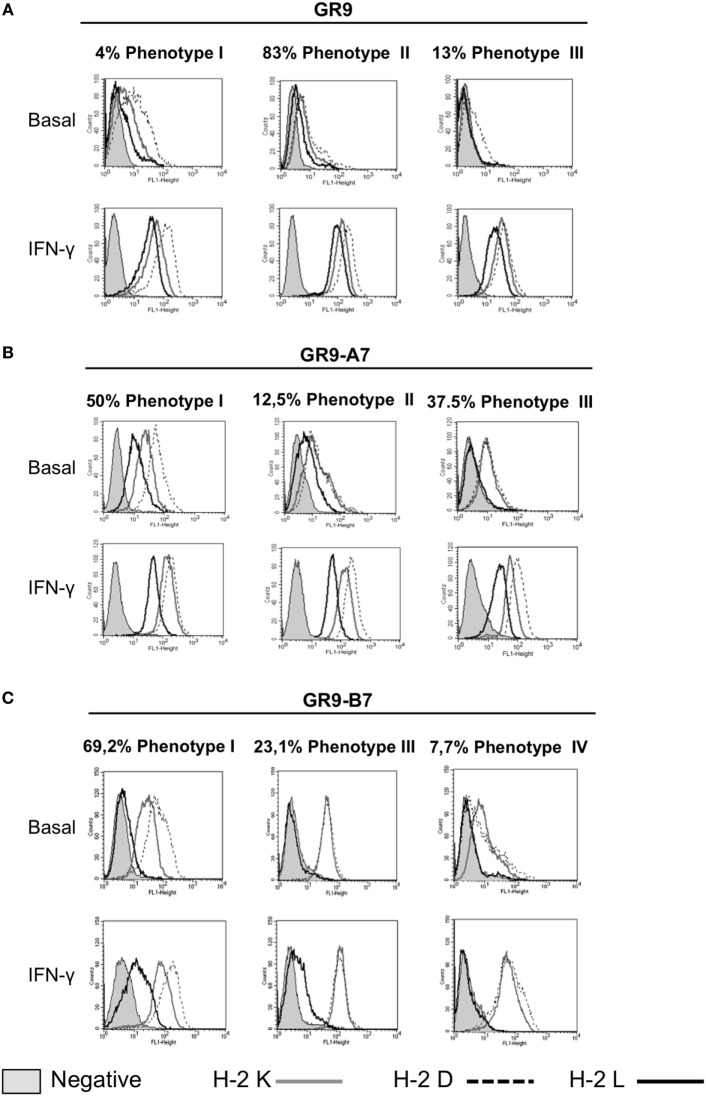
MHC-I phenotypes of GR9, GR9-A7, and GR9-B7 spontaneous metastases under baseline conditions and after treatment with IFN-γ: H-2 Kd (gray line), H-2 Dd (dotted line), and H-2 Ld (black line). Four different MHC-I phenotypes were found. (A) MHC-I phenotypes of GR9 spontaneous metastases; (B) MHC-I phenotypes of GR9-A7 spontaneous metastases; (C) MHC-I phenotypes of GR9-B7 spontaneous metastases. Data from a representative experiment are depicted.